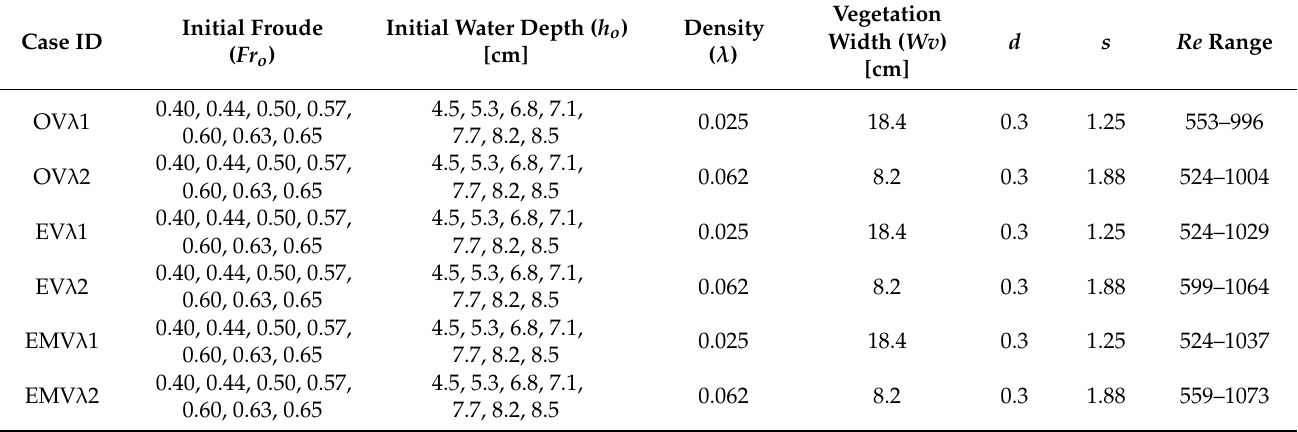
Figure 1. ( a , b ) offer distinct conceptual illustrations of the theoretical model for deriving the bulk vegetation drag coefficient, C BD ; ( c ) is the theoretical arrangement of vegetation in strips. Table 1. Presentation of the hydraulic parameters for the conducted experiments.